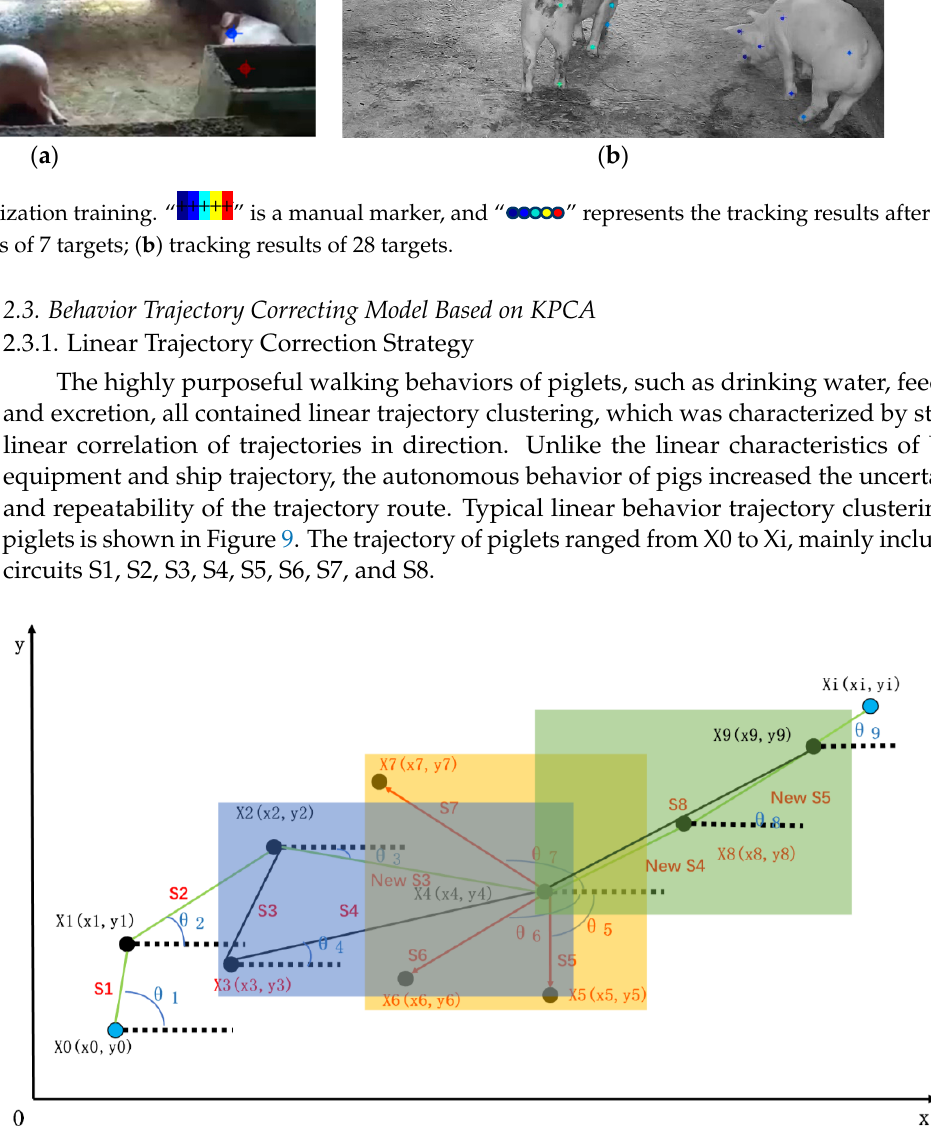
Figure 9. Linear trajectory correction strategy.